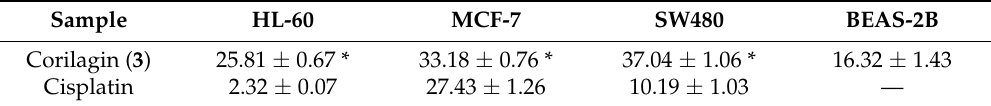
Table 1. IC 50 values ( µ g/mL) of corilagin ( 3 ) isolated from R. heudelotii against some cancer cell lines.